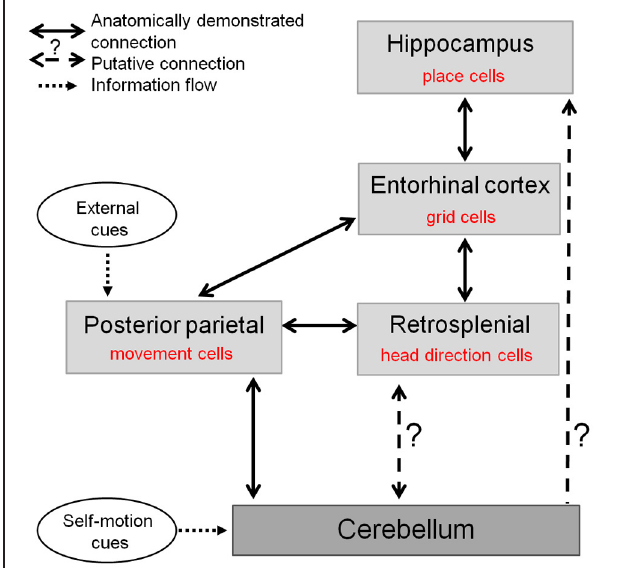
FIGURE 5 | The cerebellum in the anatomo-functional circuit underlying spatial navigation. Navigation system comprises a whole network of structures: (1) the hippocampus containing (cid:2) place cells (cid:3) , which correlate with animal’s location in space and underlie animal’s spatial representation (O’Keefe and Dostrovsky, 1971), (2) the medial enthorinal cortex, containing (cid:2) grid cells (cid:3) which fire according to a grid-like pattern and are thought to constitute the metric system of the brain (Hafting et al., 2005), (3) a network of structures—among which the retrospenial cortex—containing (cid:2) head direction cells (cid:3) , specific for a given direction of the head in space (Taube et al., 1990), and (4) posterior parietal cortex containing (cid:2) movement cells (cid:3) , encoding self-motion and acceleration (Whitlock et al., 2012). The cerebellum takes part in this navigation system as it shapes hippocampal place cells properties (Rochefort et al., 2011). This contribution could occur either through a direct projection to the hippocampus or via a multi-synaptic connection involving a thalamic relay, to the posterior parietal cortex or the retrosplenial